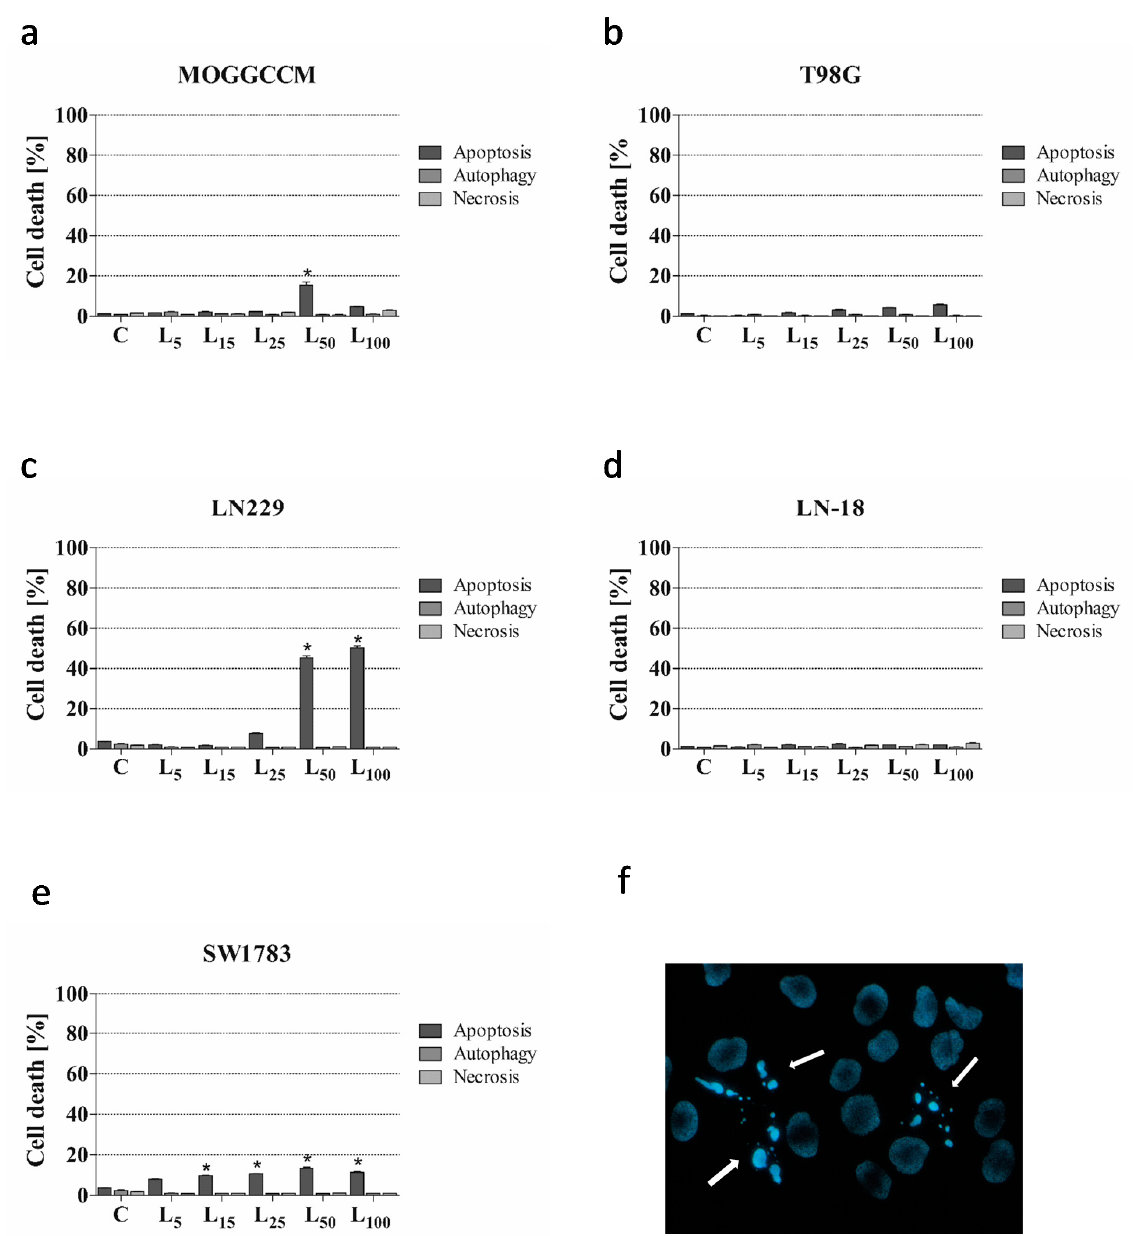
Figure 1. Effect of different concentrations of lensoside A β on the level of apoptosis, autophagy, and necrosis, identified microscopically after staining with Hoechst 33342, acridine orange, and propidium iodide, respectively, in anaplastic astrocytoma (MOGGCCM, LN229, SW1783; ( a , c , e )) and glioblastoma multiforme cells (T98G, LN-18; ( b , d )) incubated with the compound for 24 h. ( f ) Representative picture of apoptotic MOGGCCM cells (pointed by arrows) stained with Hoechst 33342 after 50 µM lensoside A β treatment; C—control; * p < 0.01 compared to the control.